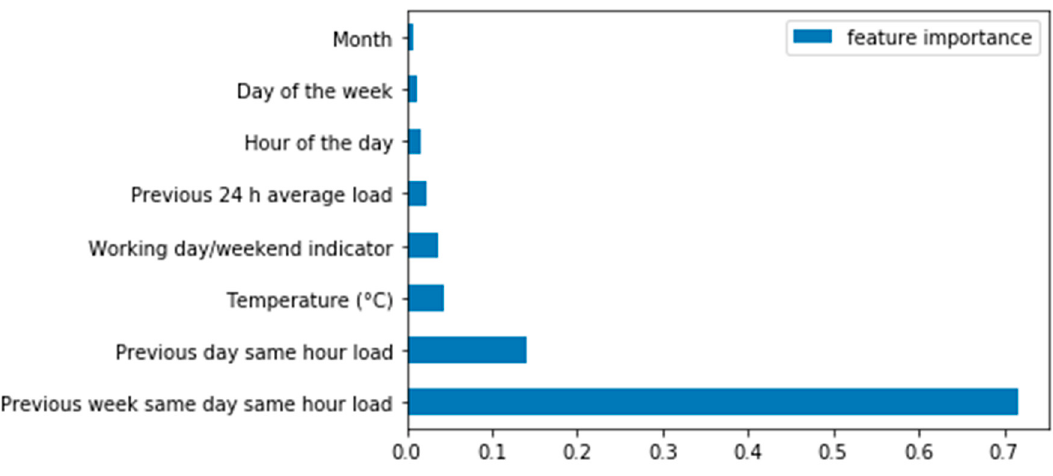
Figure 10. Feature Importance.